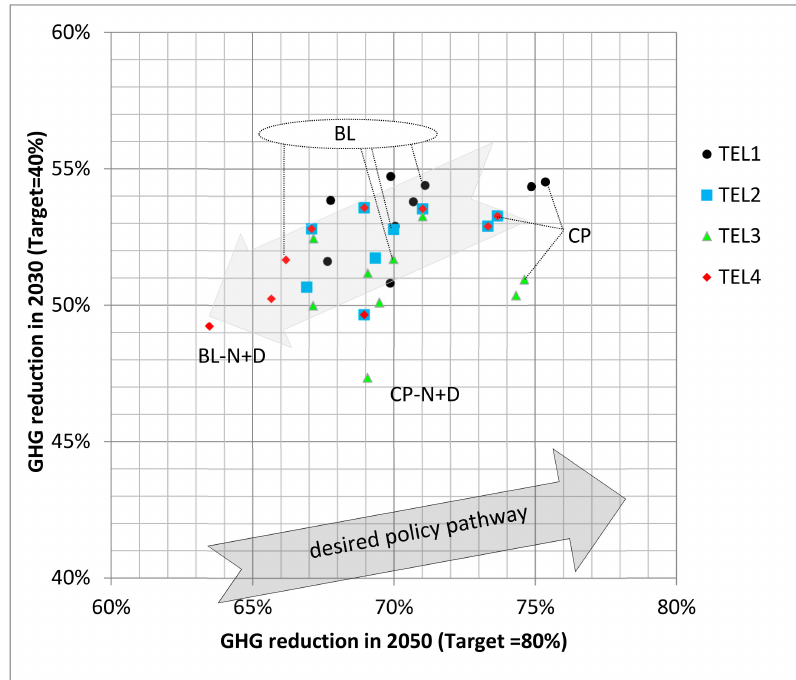
Figure 12. GHGs emissions reductions in 2030 and 2050, the 2030- and 2050-targets compared to the 1990 reference level. Note: Green triangles are always lower than blues and reds, indicating TEL3 is worse to reach the 2030 40% target than TEL2 (blue) and TEL4 (red). The reds are always more on the left (or at the same position) as green or blue, indicating missing the 2050 target most. The black circles are always on the top and on the right, showing that TEL1 has the best performance to reach both 2030 and 2050